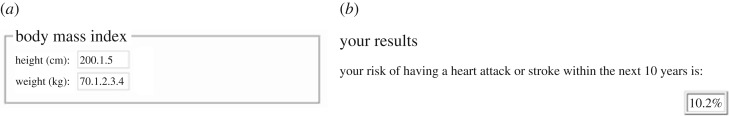
Screen shots from QRISK2, a clinically-validated risk calculator, available at www.qrisk.org. (a) Invalid numerals entered as data; (b) apparently valid result. Note that no errors are reported by QRISK2, so the user may be unaware of any problems, and then will act inappropriately. These screen shots were taken in October 2016.